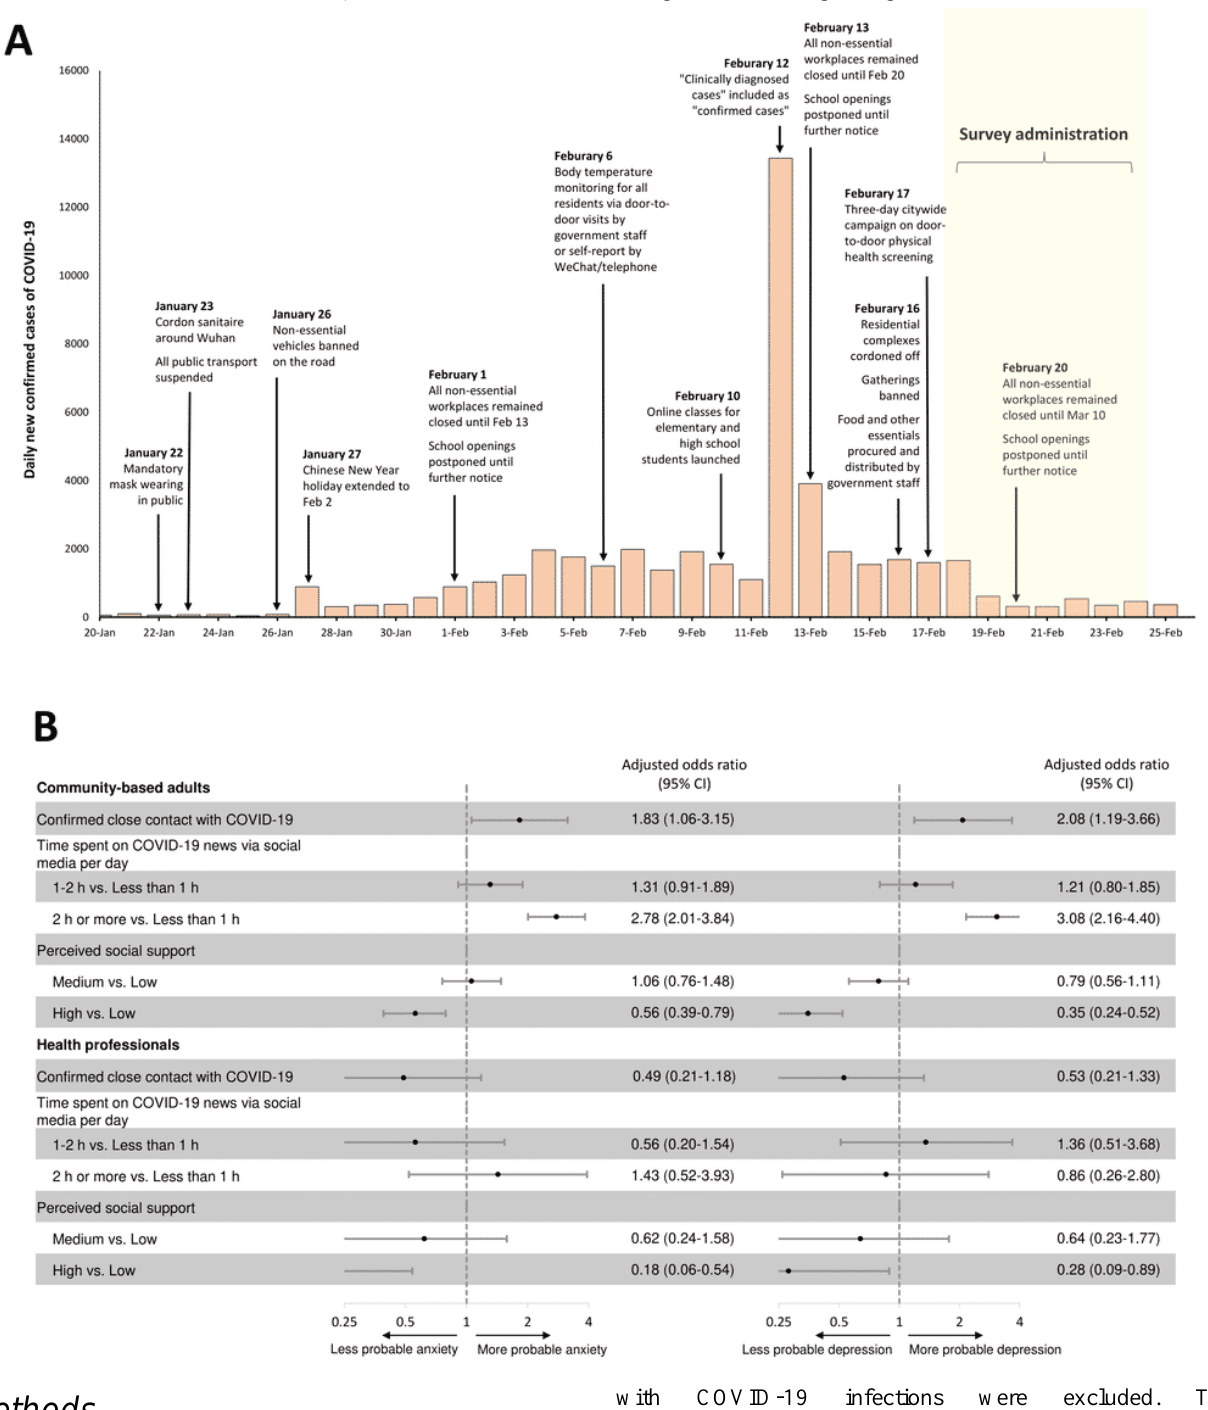
Figure 1. (A) Chronology of the cordon sanitaire and nonpharmaceutical interventions in Wuhan, China in 2020. The number of new confirmed cases of COVID-19 from the Health Commission of Hubei Province. (B) Risk factors of probable anxiety and probable depression during the COVID-19 epidemic and cordon sanitaire around Wuhan, China. Odds ratios are obtained through multivariable logistic regression. COVID-19: coronavirus